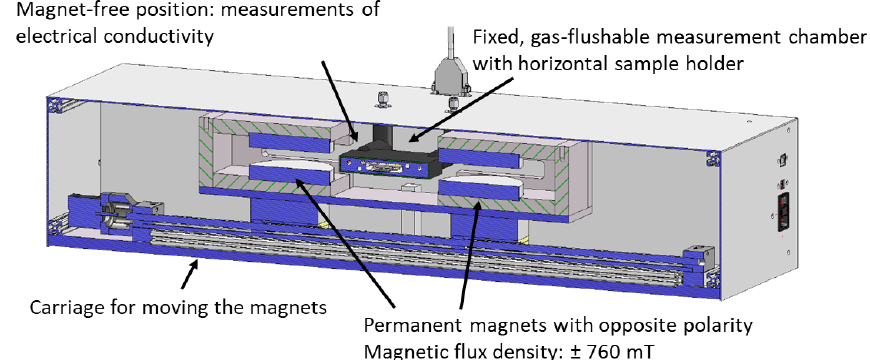
Figure 7. Hardware structure showing two movably mounted magnetic yoke systems of permanent magnets on a sledge for measurements without and in positive/negative magnetic